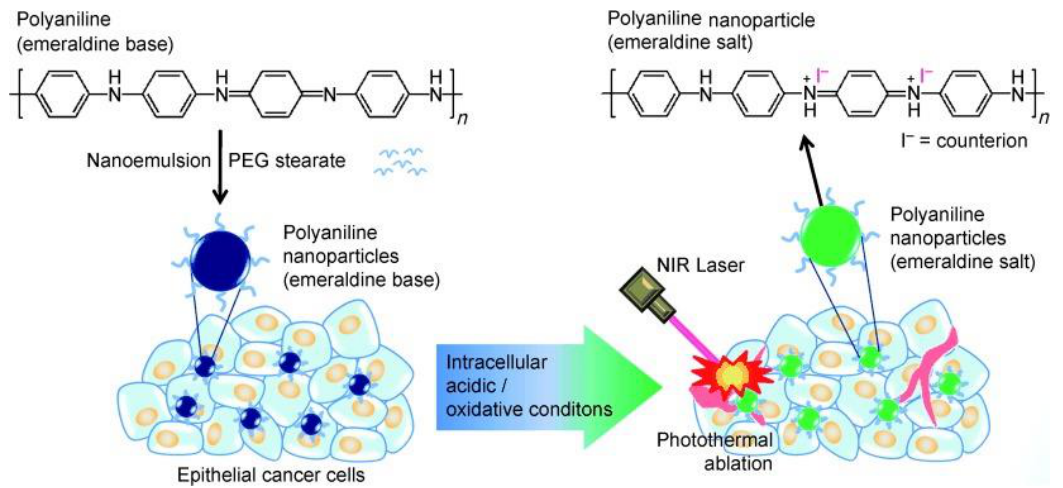
Figure 2. Schematic illustration of the preparation of polyaniline nanoparticles and their application for the photothermal ablation of epithelial cancer cells by NIR laser irradiation (image is reproduced from [14] with the copyright permission from WILEY-VCH Verlag GmbH & Co.).